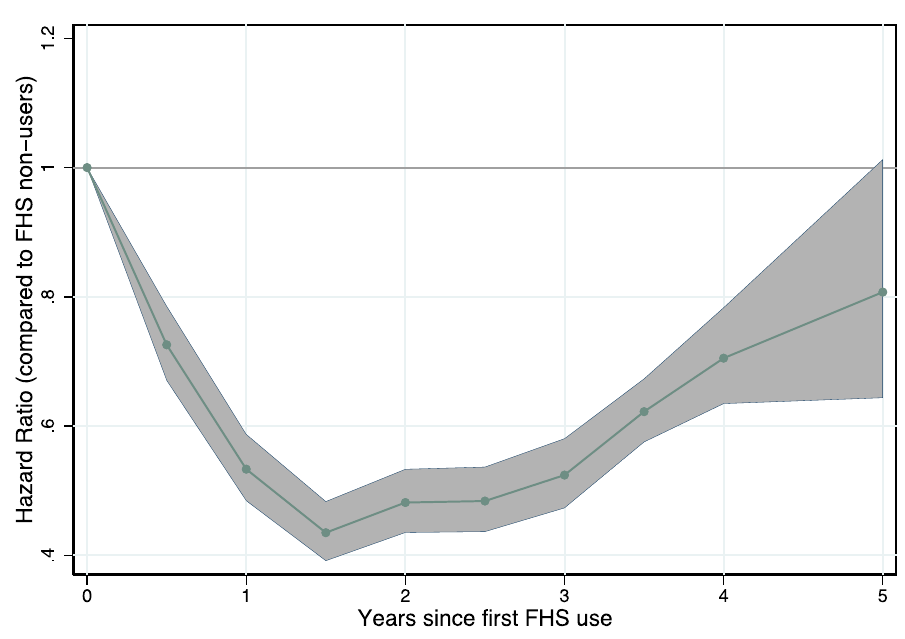
Fig 2. HRs for all-cause mortality by length of time since first usage. Estimated HRs obtained from flexible parametric survival models with IPTW and regression adjustment for sex, race/ethnicity, age at cohort entry, highest level of education, disability, unemployment, household per capita income decile, number of family members per bedroom, family size, number of children in family, household flooring, household piped water access, quintiles of household expenditure on medicines, quintile of per capita household expenditure on food, formal labor employment, formal labor employment in the family, whether the family receives Bolsa Familia or not, and whether the individual has been hospitalized before FHS use. HRs for lengths of time since first observation are interpreted relative to those without any FHS use. FHS, Family Health Strategy; HR, hazard ratio; IPTW, inverse probability treatment weighting.